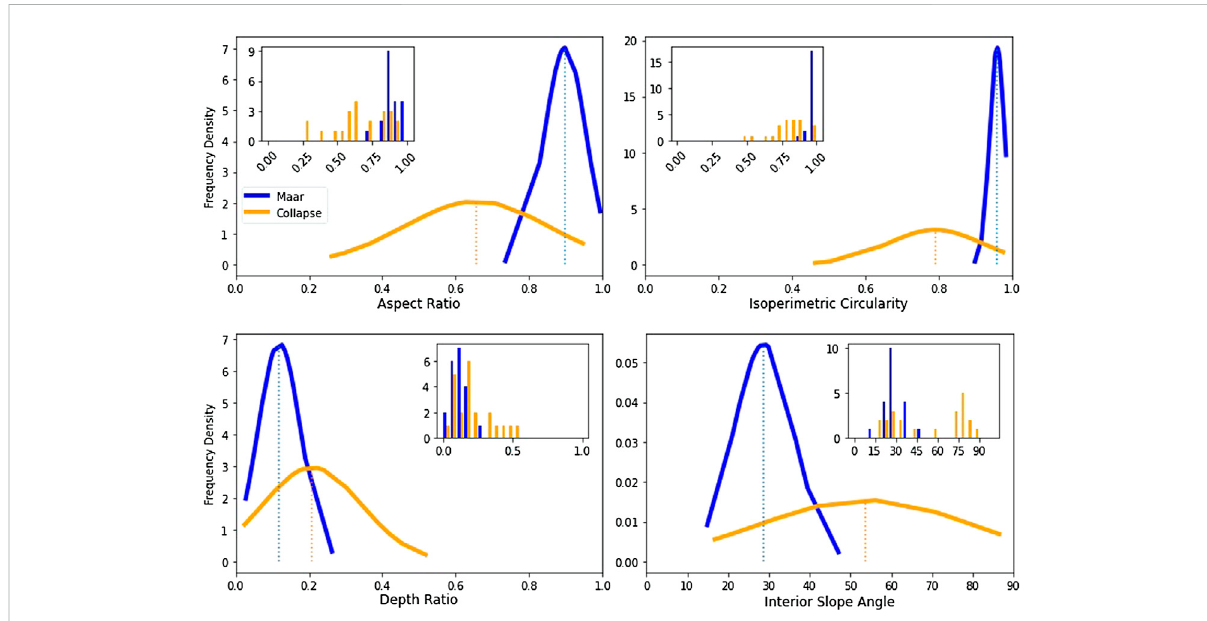
FIGURE 5 Frequency distribution of identi fi ed negative volcanic landforms parameters. Simple maars in this study (N = 20) are a representative range of sizes and shapes from three continents. Maar parameters (blue) all fall in a very distinct range; aspect ratio > 0.73, isoperimetric circularity > 0.89, interior slope angle < 47.7, and depth ratio < 0.26. Collapse features (N = 22) are representative sizes and shapes from three North American sites. Collapse features in this study are those formed by collapsed lava surfaces into a void. Collapse features morphometry parameters (orange) have a wider range variance; aspect ratio > 0.26, isoperimetric circularity > 0.46, interior slope angles < 87 °